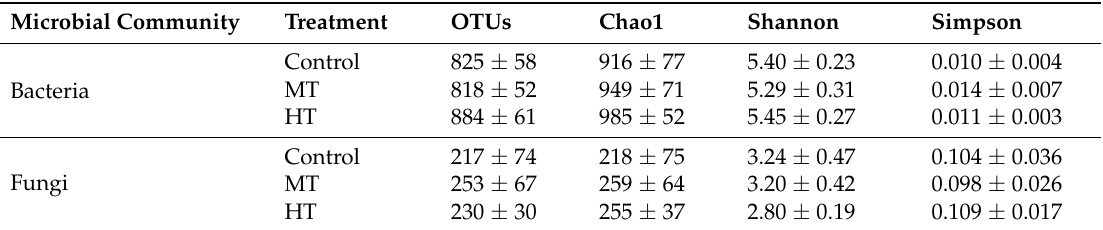
Table 3. Bacterial and fungal diversity indices in the three thinning treatments; Control: conventional management model, MT = moderate thinning, and HT = heavy thinning; n = 3, mean ± SD.